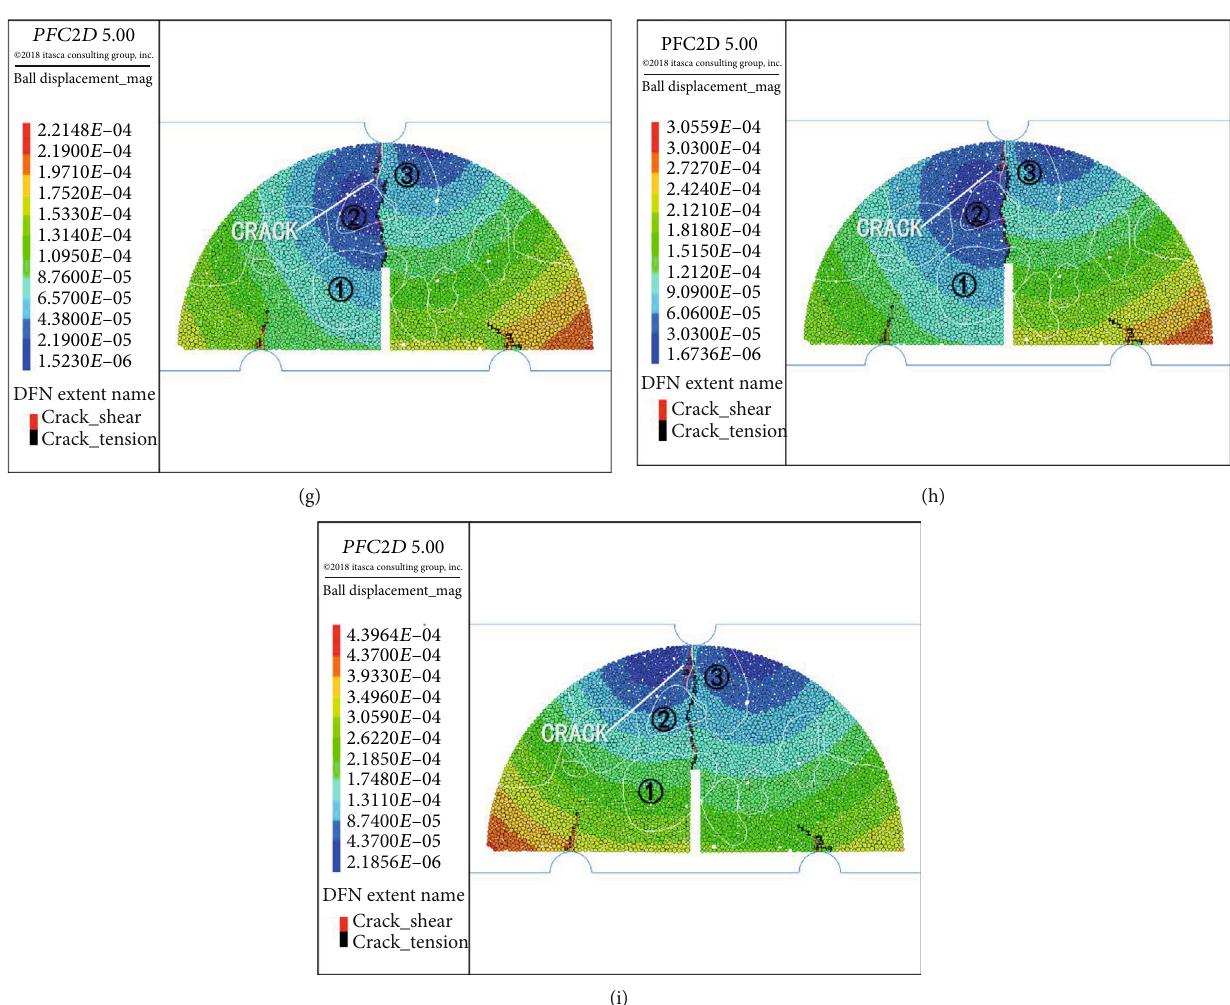
Figure 13: Test C crack growth process. The fi gures show the change trend of the displacement fi eld (Ball displacement_mag) during the crack propagation process of the simulation of the Group C. The black and red lines above the prefabricated crack are the destruction of the bond chain of the bonding elements (balls), which represent the fracture